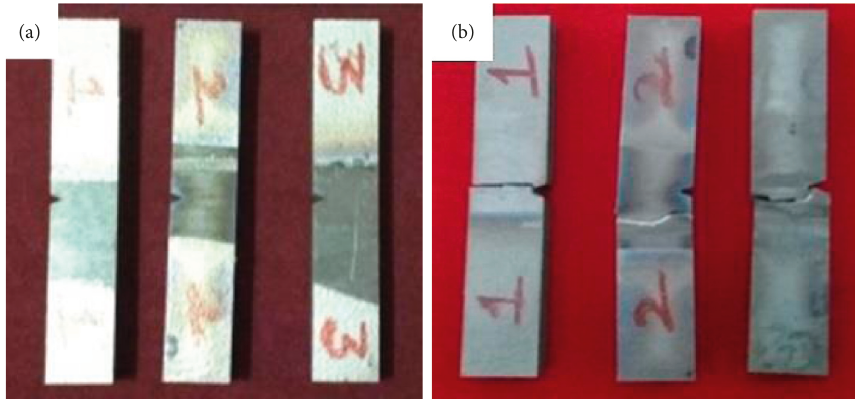
Figure 14: Photograph of impact toughness